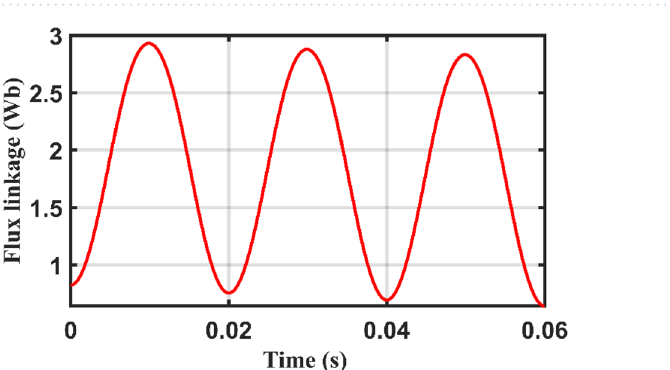
Figure 11. Simulation Inrush current.